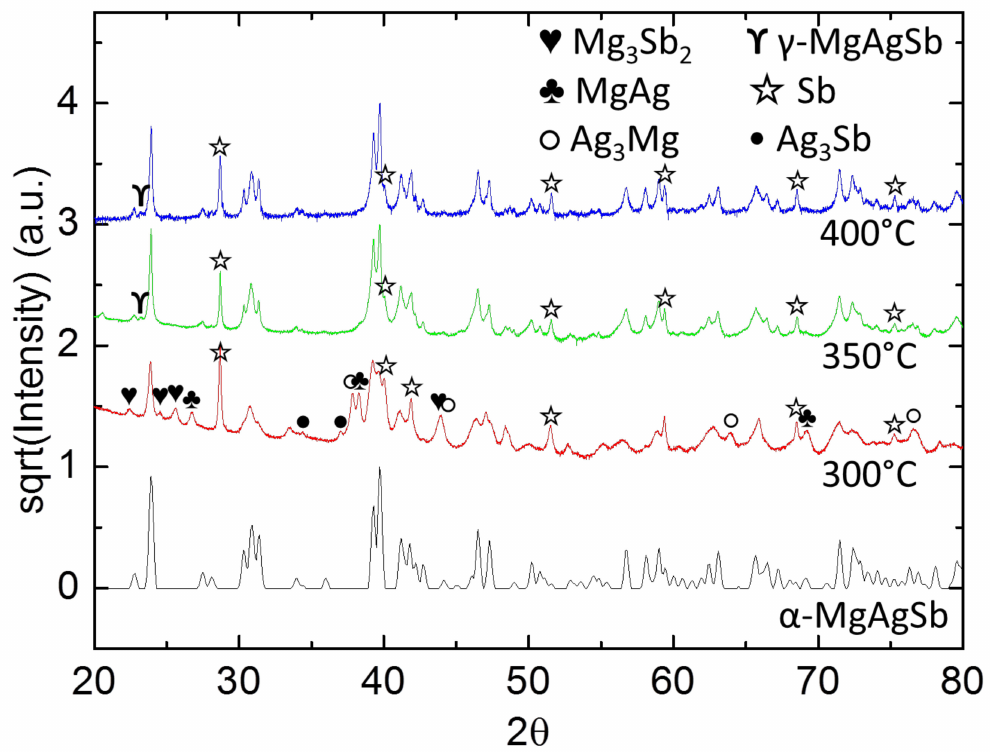
Figure5. XRDinvestigationofsampleswithdi ff